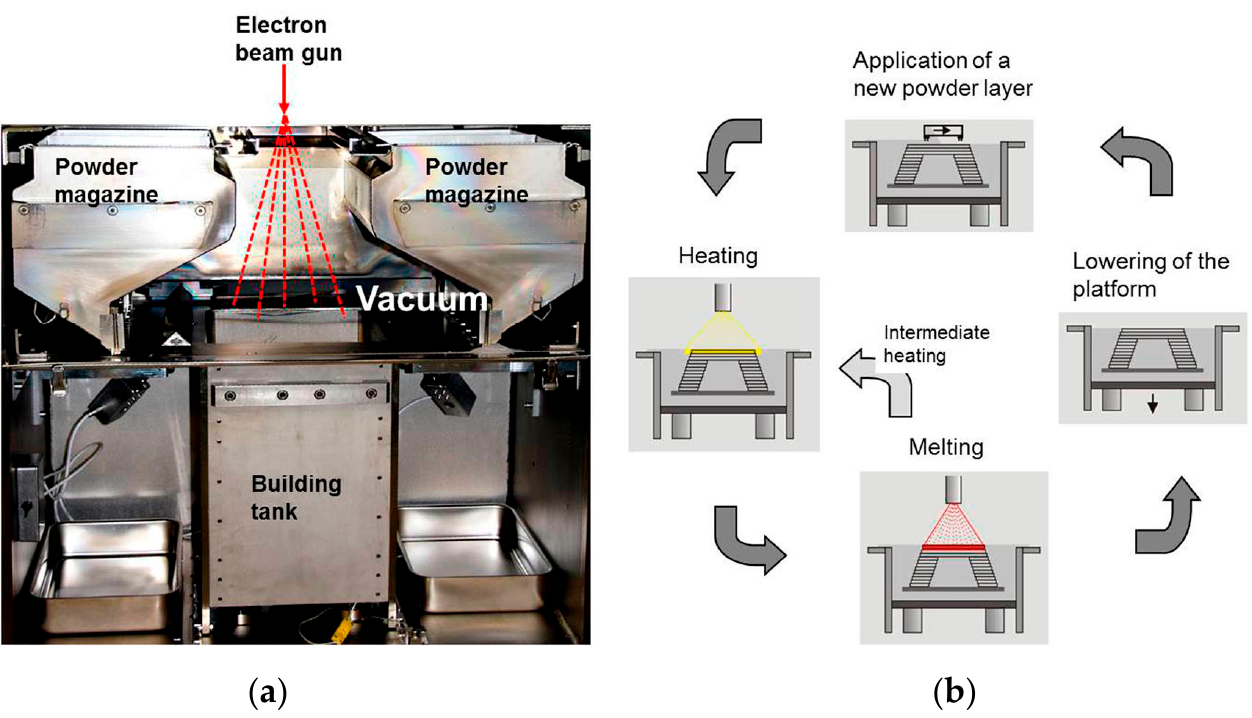
Figure 3. The EBM equipment and forming schematic diagram: ( a ) the equipment of EBM; ( b ) 4-step process for building one layer. Reprinted with permission from Ref. [81]. Copyright 2016, copyright Körner C.